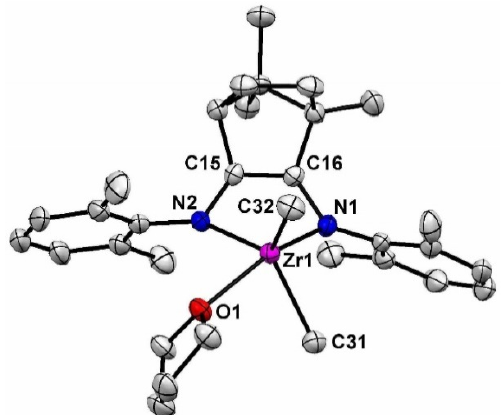
Figure 1. Molecular structure of 1-Zr . Selected distances (Å) and angles (deg): Zr1–N1 2.067(3), Zr1–